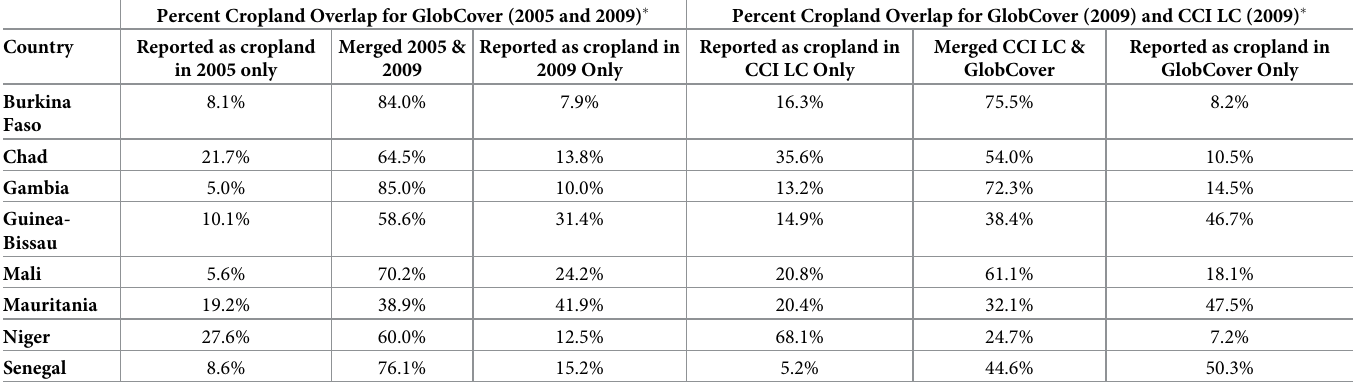
Table 3. Differences in impacted cropland with reported corn and cotton production based on distinct versions of global land cover datasets. Percentages are based on the combined datasets area and not on an individual GlobCover dataset. Percent Cropland Overlap for GlobCover (2005 and 2009) �